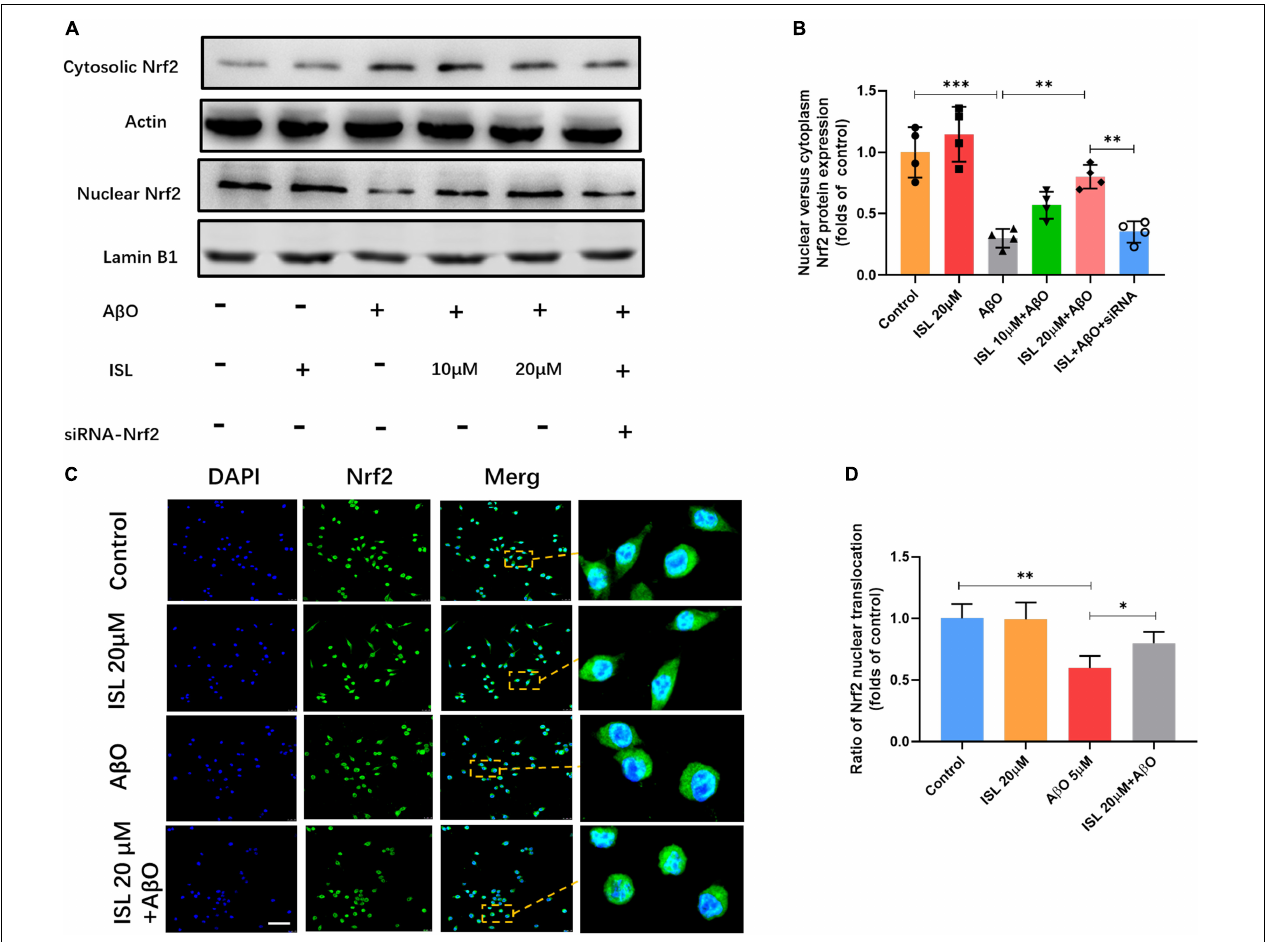
FIGURE 7 | The expression of Nrf2 in nucleus and cytoplasm. BV2 cells, including those transfected by Nrf2 siRNA, were pre-treated with ISL for 2 h and then co-treated with 5 µ M A β O for 24 h. (A,B) Protein expression of cytosolic and nuclear Nrf2 were analyzed by Western blot. (C,D) The translocation of Nrf2 (green) to the nucleus (blue) is shown by confocal microscopic images. Scale bar: 50 µ m. ∗ p < 0.05, ∗∗ p < 0.01, ∗ ∗ ∗ p < 0.001. n = 4 per group for Western blot and n = 6 for immunofluorescence